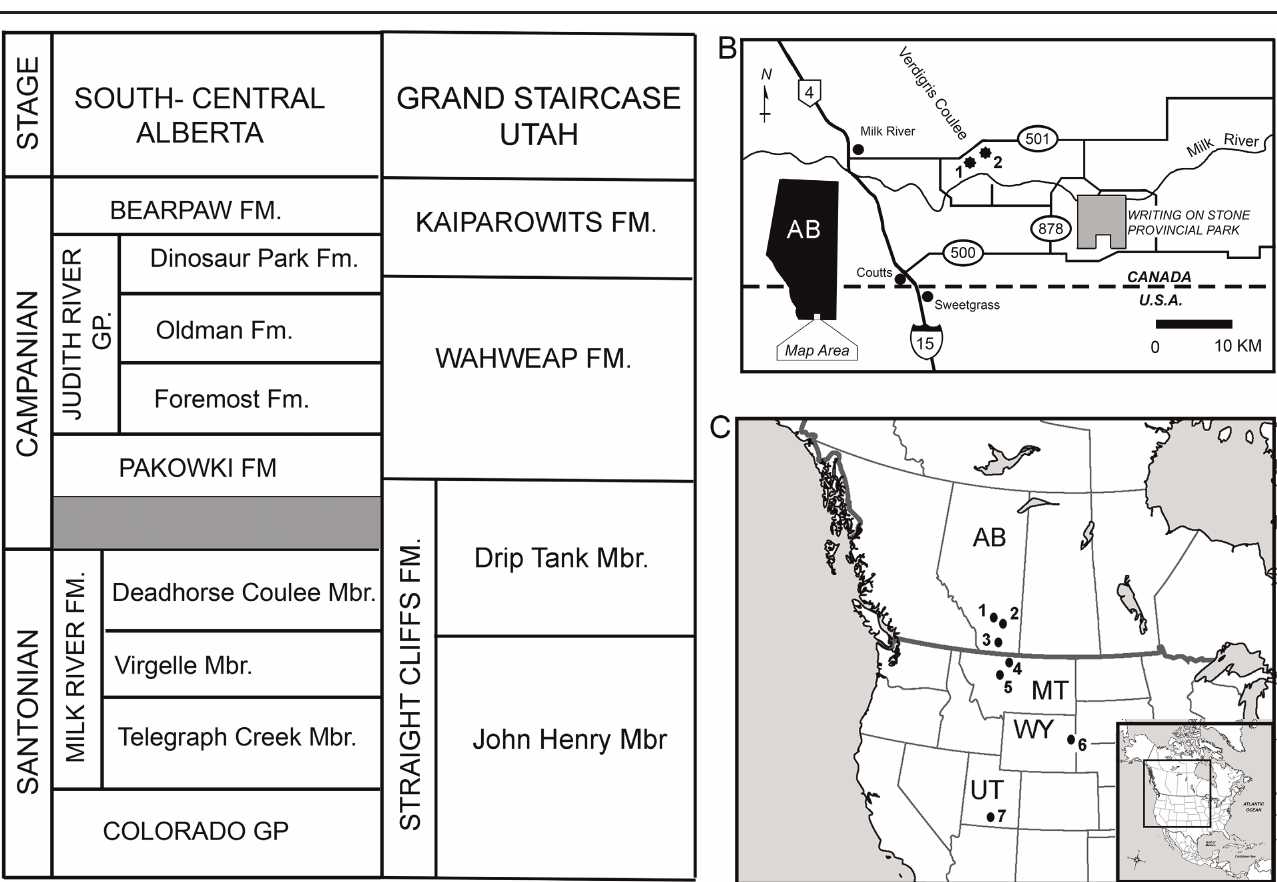
Figure 1. A) stratigraphic chart showing the formations in South-central Alberta and the correlation with formations in the Grand Staircase region of Utah. The ages of the formations in Alberta are based on Braman (2002). The correlation of the formations of Utah and Alberta is from Brinkman et al. (2013). B) locality map showing the position of vertebrate microfos